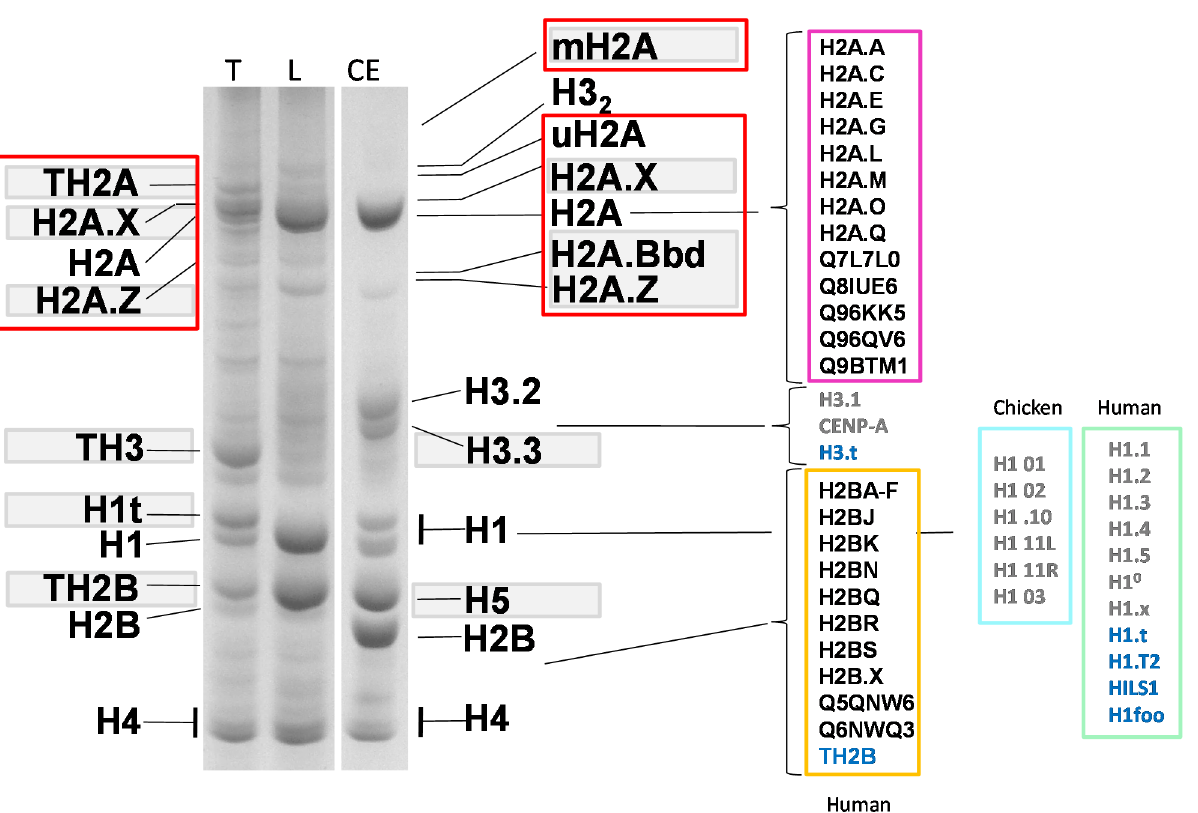
Figure 1. Acetic acid (5%) urea (5M) -triton (0.3%) polyacrylanmide gel electrophoresis of HCl-extracted histones from nuclei of: CE (chicken erythrocyte); L (rat liver) and T (rat testes). The replacement histone variants are highlighted with a grey background, and the different types for the canonical variants are also indicated. Members of the histone H2A family are highlighted by red squares to underscore the large number of variants within this family. Names in light blue on the right hand side of the image correspond to the germline variants. For clarity, the old histone nomenclature has been used in this figure. For equivalence to the newly unified phylogeny-based nomenclature, the reader is referred to